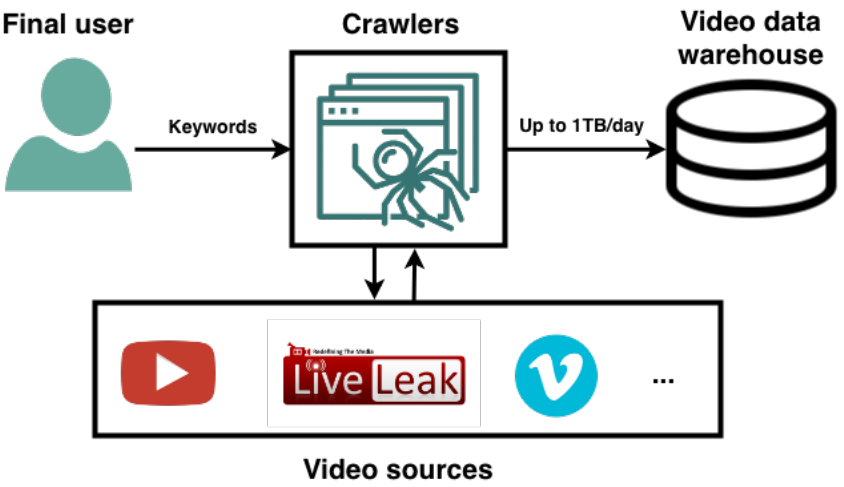
Figure 3. Proposed system for storage of retrieved